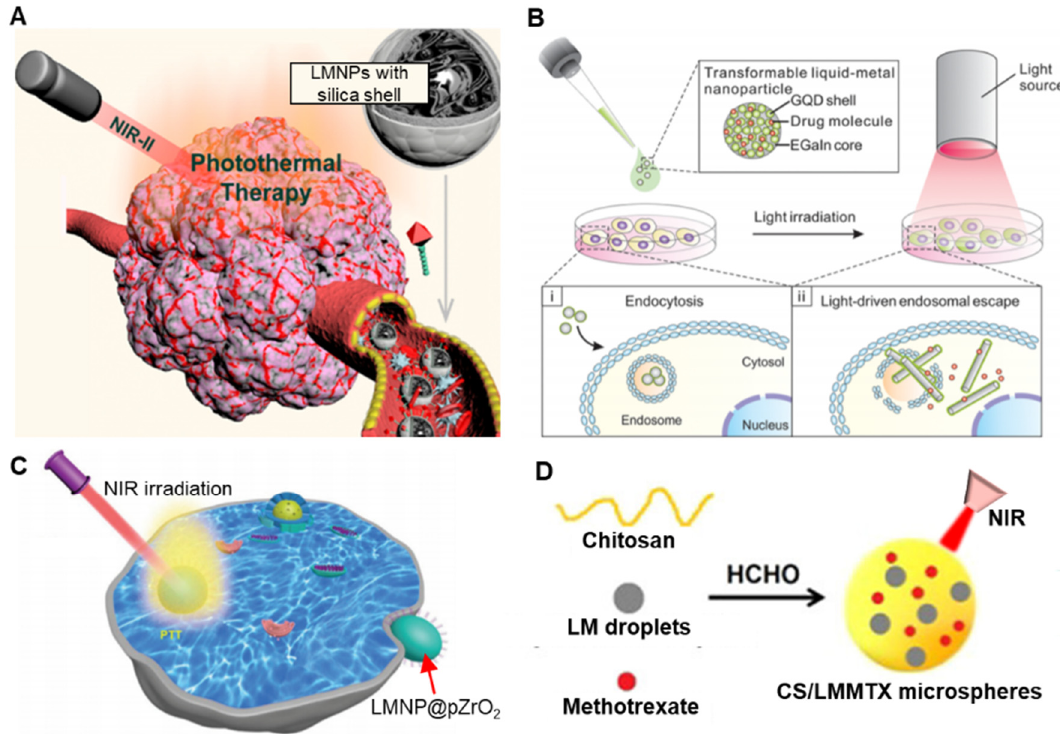
Figure 6. Di ff erent modification strategies of LMNPs for cancer treatment. ( A ) Demonstration of silica-coated LMNPs loaded with doxorubicin (DOX) for photothermal therapy (PTT). Reproduced with permission from ACS [54]. ( B ) Multi-functional GQD-coated LMNPs that can deliver DOX and disrupt the interior of cancer cells via shape transformation. Reproduced with permission from ACS [14]. ( C ) Demonstration of LMNPs-coated with ZrO 2 for PTT. Reproduced with permission from RSC [58]. ( D ) Microspheres incorporating chitosan, Ga liquid metal, and methotrexate for PTT. Reproduced with permission from ACS [59].